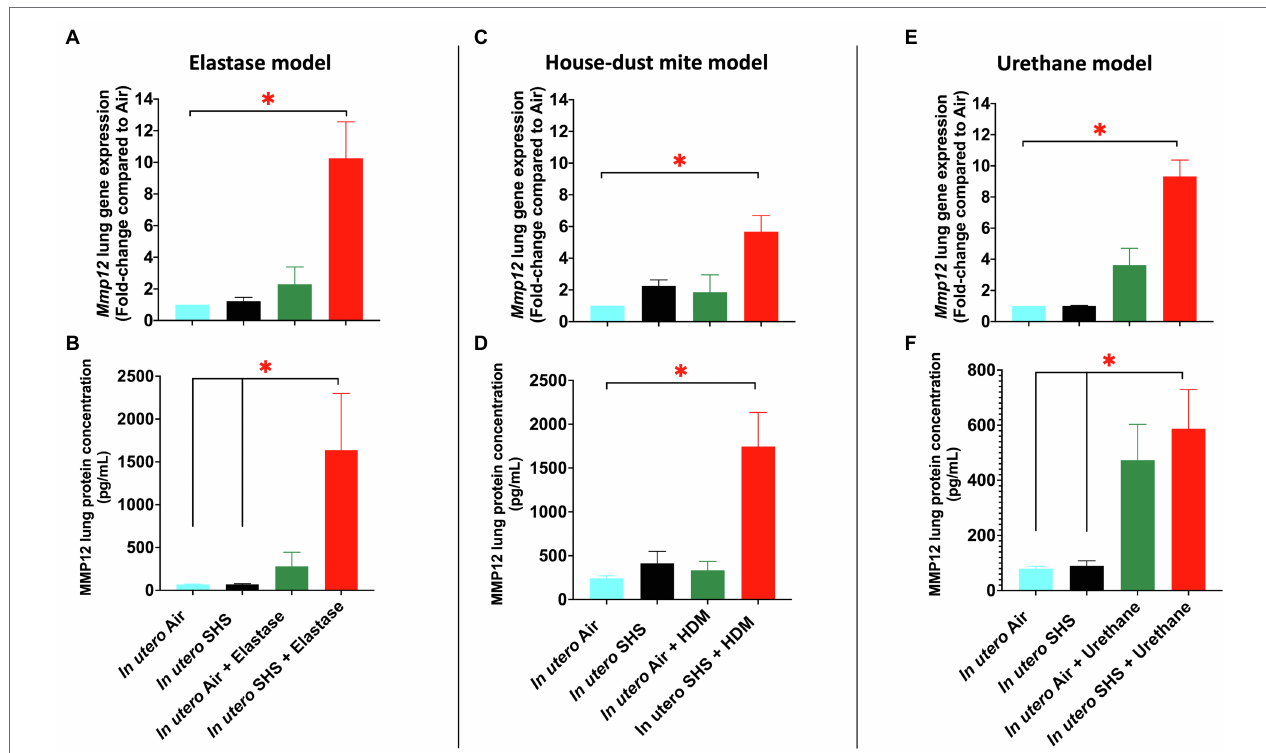
FIGURE 14 | In utero SHS exposures increased MMP12 gene and protein expression in three distinct adult lung disease models. (A) Mmp12 lung gene expression results obtained by qPCR in the in utero SHS plus elastase-induced emphysema model. N = 4–5 per group. Data are expressed as mean per group. Gene expression data are displayed as fold-changes compared to the in utero air plus saline control group. * p < 0.05: statistically different from all other groups. (B) MMP12 lung protein expression results obtained by multiplex assay in the in utero SHS plus elastase-induced emphysema model. N = 4 per group. Data are expressed as mean ± SEM. ANOVA, followed by the Tukey’s test for multiple comparisons, * p < 0.05: statistically significant. (C) Mmp12 lung gene expression results obtained by qPCR in the in utero SHS plus HDM-induced asthma model. N = 9–10 per group. Data are expressed as mean per group. Gene expression data are displayed as fold-changes compared to the in utero air plus saline control group. * p < 0.05: statistically different from all other groups. (D) MMP12 lung protein expression results obtained by multiplex assay in the in utero SHS plus HDM-induced asthma model. N = 4 per group. Data are expressed as mean ± SEM. ANOVA, followed by the Tukey’s test for multiple comparisons, * p < 0.05: statistically significant from all other groups. (E) Mmp12 lung gene expression results obtained by RT2-PCR array in the in utero SHS plus urethane-induced lung cancer model. N = 4 per group. Data are expressed as mean per group. Gene expression data are displayed as fold-changes compared to the in utero air plus saline control group. * p < 0.05: statistically different from all other groups. (F) MMP12 lung protein expression results obtained by multiplex assay in the in utero SHS plus urethane-induced lung cancer model. N = 4 per group. Data are expressed as mean ± SEM. ANOVA, followed by the Tukey’s test for multiple comparisons, * p < 0.05: statistically